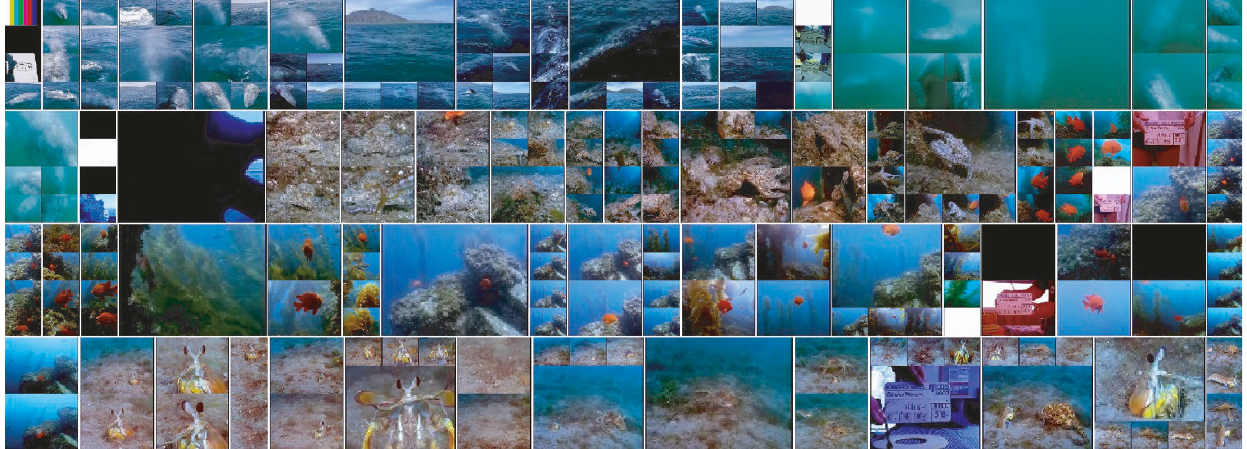
Figure 9: A page layout for parameters N = 250 and R = 1 / 3.